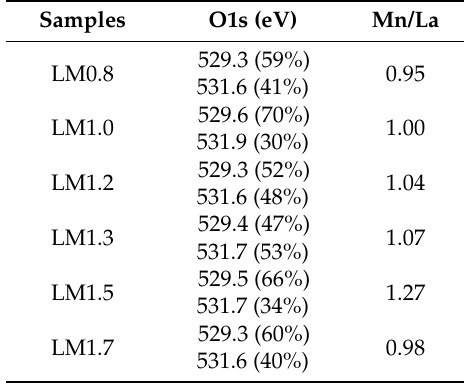
Table 3. BE of O1s and Mn2p of selected LM oxides and Mn/La atomic ratio. In parentheses the relative percentage of the two O1s components are